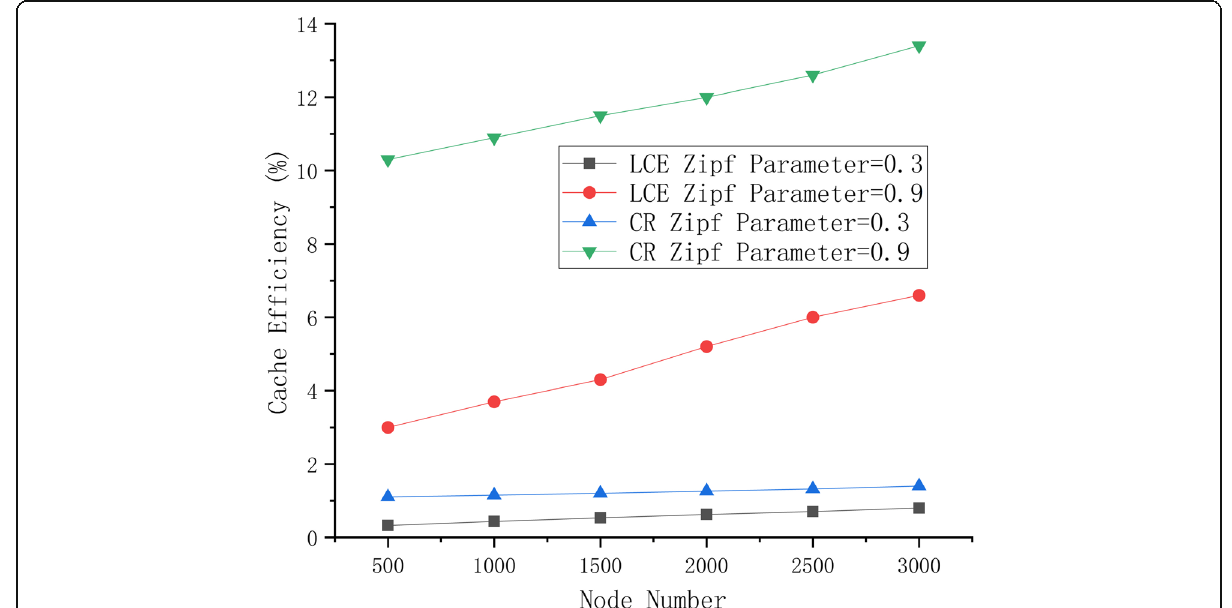
Fig. 12 Cache efficiency vs. number of nodes. The figure plots the cache efficiency with respect to number of nodes in the whole network. Results show that CR provides a more stable performance in lower number nodes scenario compared to higher ones than that of